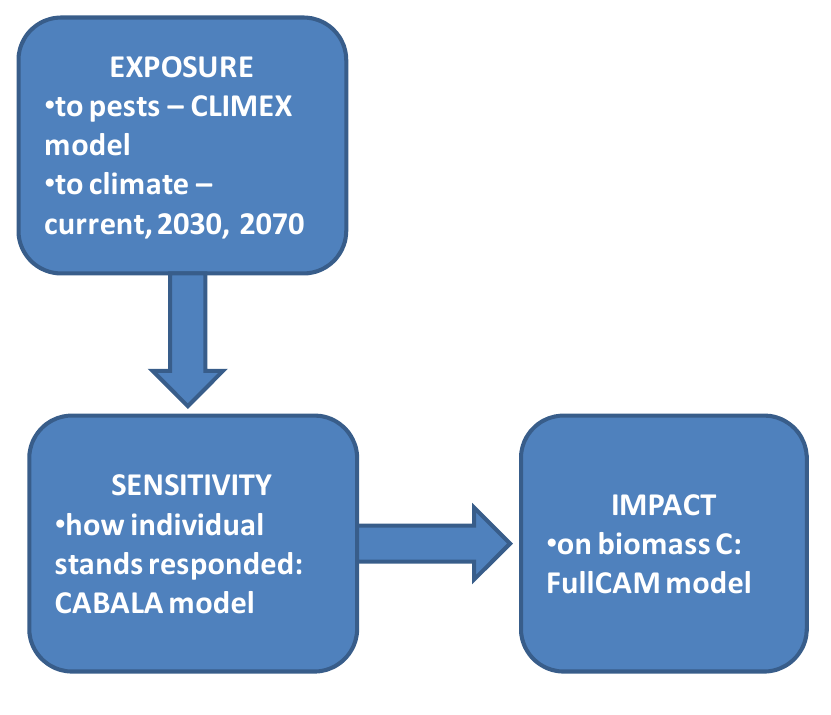
Figure 1. The framework used for the analysis of impact of defoliation on biomass carbon sequestration in eucalypt plantations. Exposure to pests was defined using previously published data on severity and frequency of pest outbreaks at the sites selected for the study